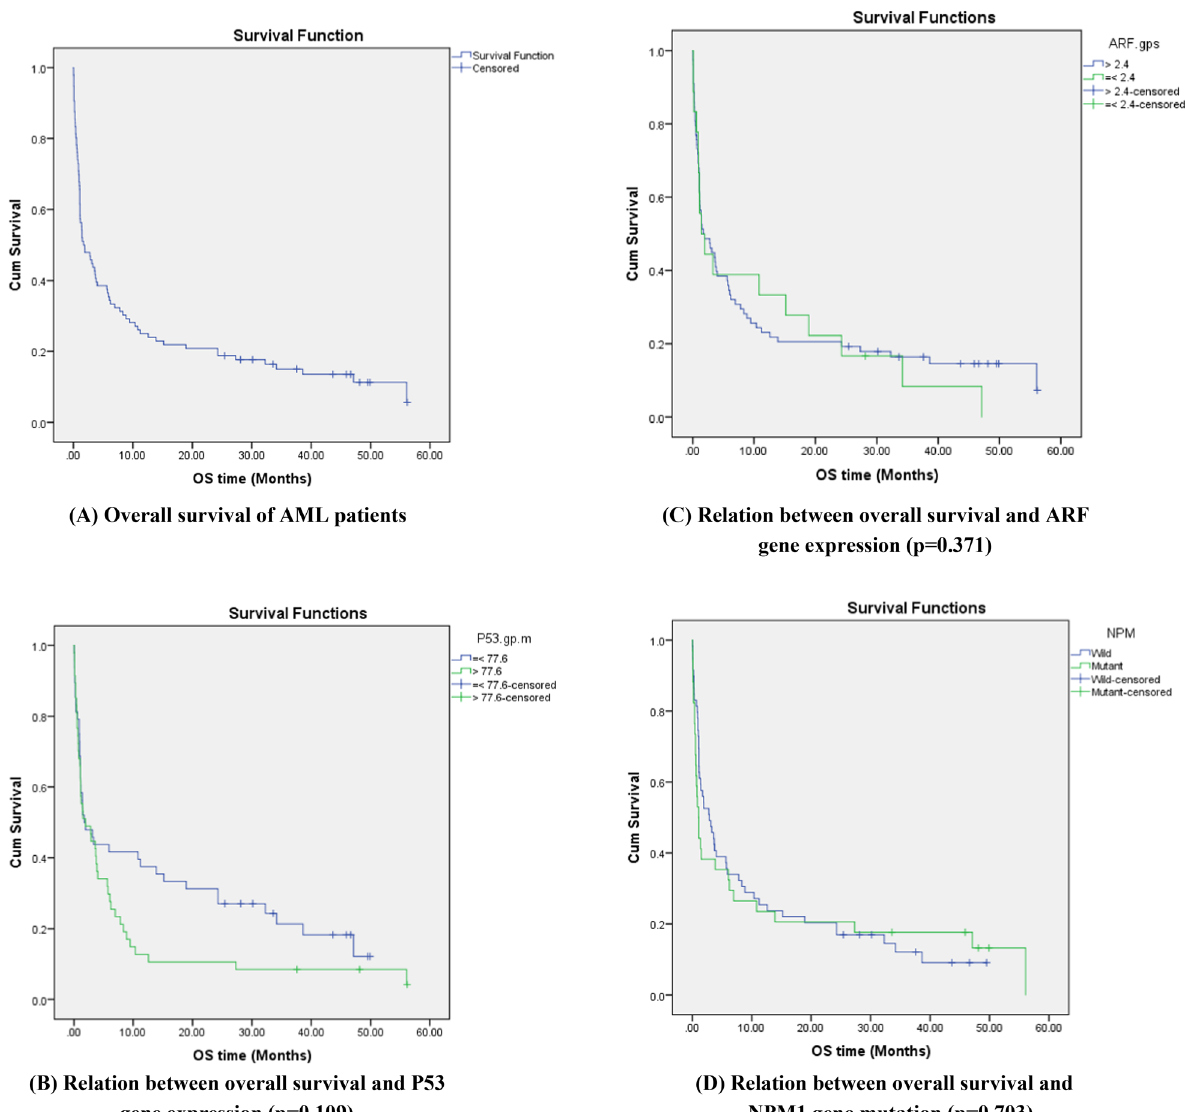
Fig. 2 Kaplan–Meier curves of survival analysis of AML in relation to genes